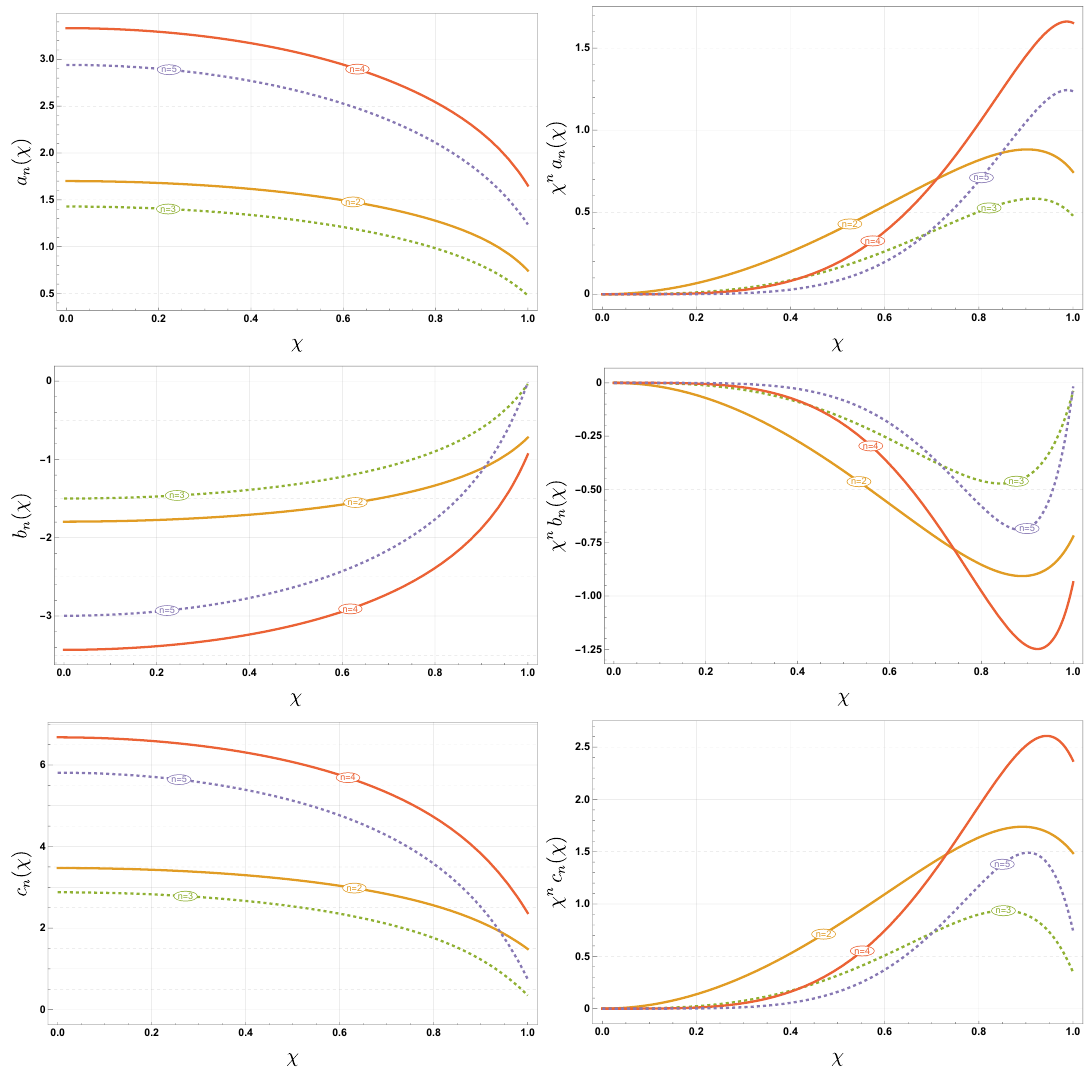
Figure 7 . From top to bottom: relative (left) and absolute (right) corrections to the multipole moments associated to the dilaton-Gauss-Bonnet theory (coefficients a n ), dynamical Chern-Simons theory (coefficients b n ) and the parity-breaking interaction term (coefficients c n ) . The coefficients a n , b n and c n are defined in (4.24) and represent the relative corrections to the complex multipoles Z n , while the absolute correction is proportional to these coefficients times χ n